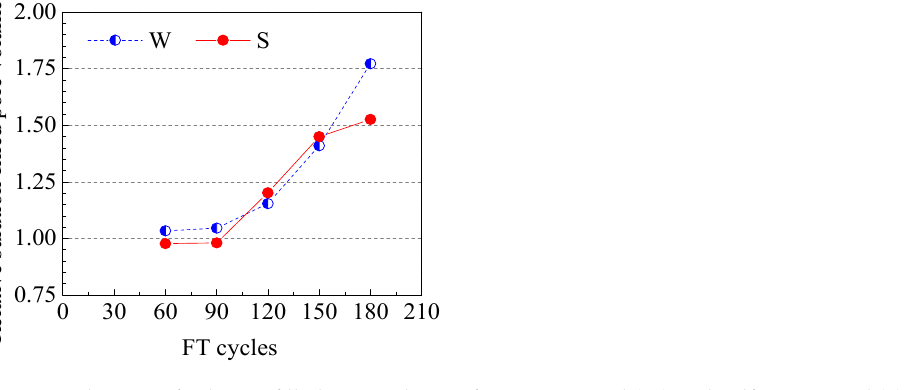
Figure 5. Changes of solution-filled pore volume of water-exposed (W) and sulfate-exposed (S) RAC samples at different freeze–thaw cycles.